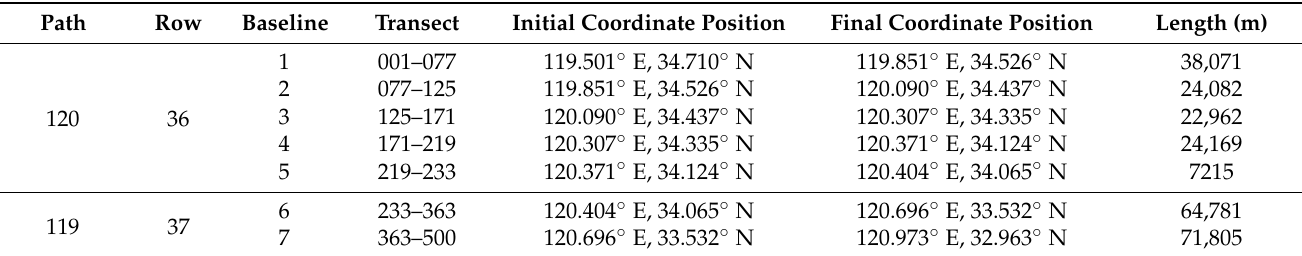
Table 1. Coastline baselines basic